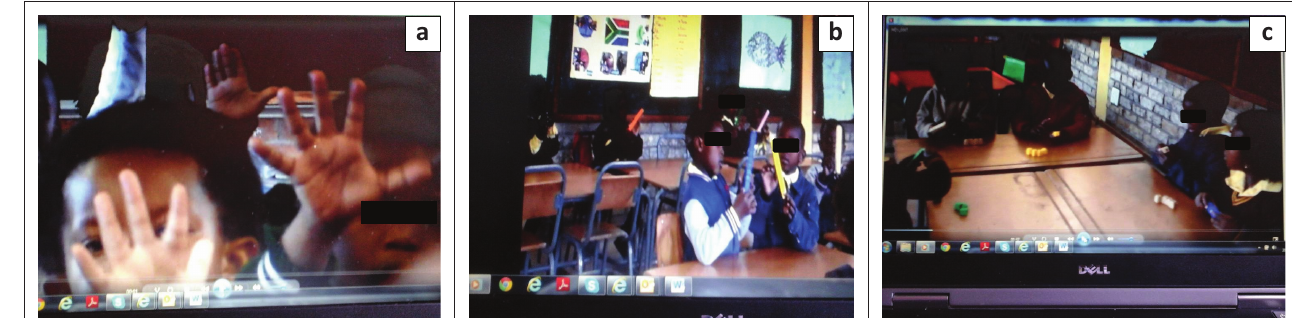
FIGURE 6: Using fingers and manipulatives to